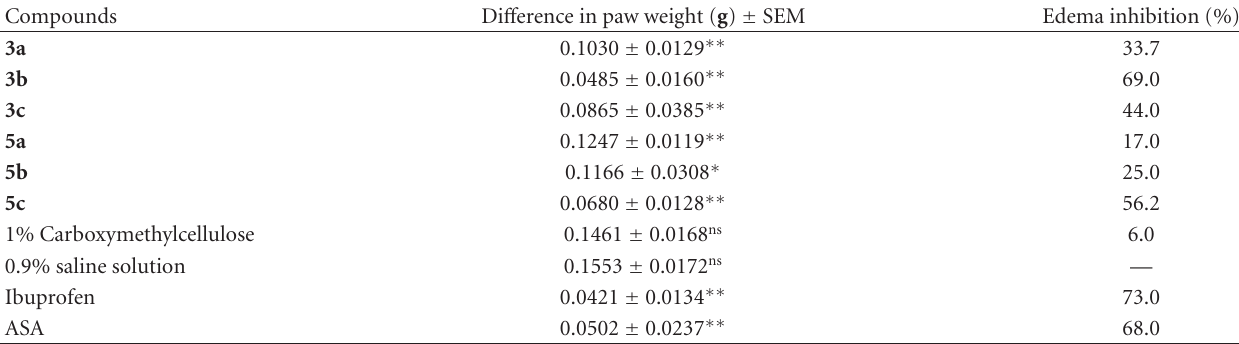
Table 1: Acute anti-inflammatory activity of 1,2,3-triazole phthalimides 3a–c and 5a–c after carrageenin-induced edema at dose 250mg · kg − 1 .